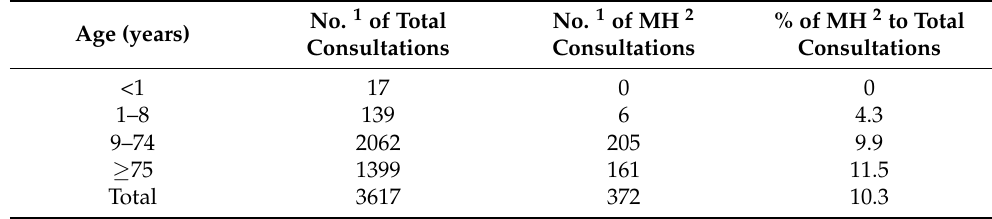
Table 1. Summary of total and mental health consultations during the West Japan Heavy Rain